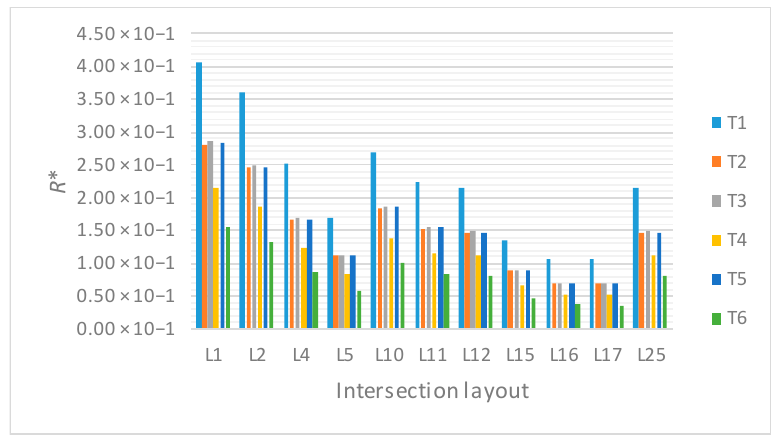
Figure 7. Risk of collision for layouts derived from L1 and L2.